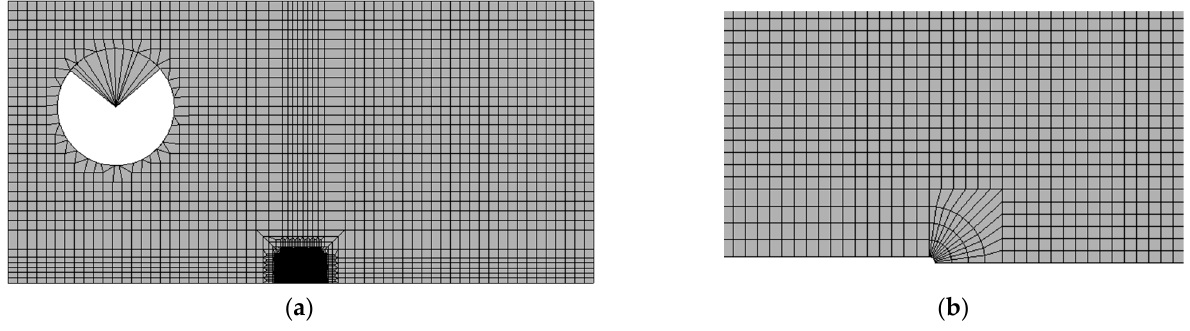
Figure 3. ( a ) 2D half 1T compact tension specimen model; ( b ) Uniform mesh design with a finite radius crack tip.